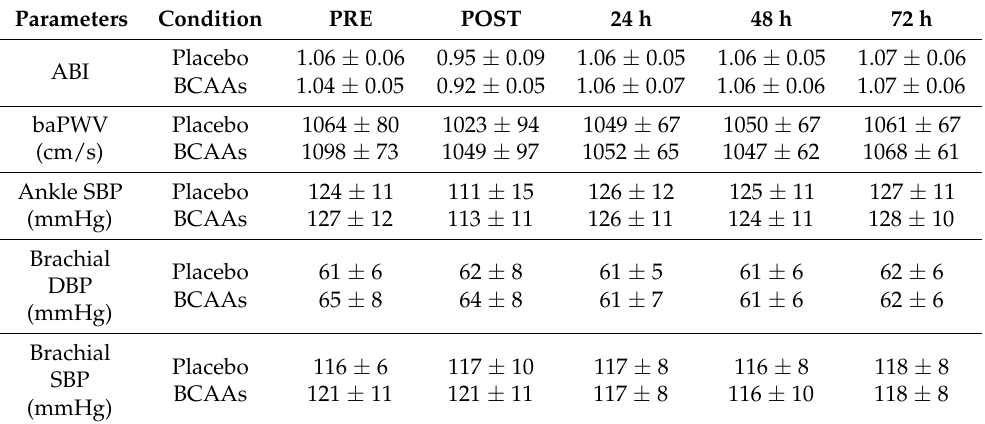
Figure 7. COD deficit time during the time course of recovery. (*) Denotes differences ( p < 0.05) from all time-point measurements. Table 1. Changes of vascular health variables for BCAAs and placebo supplementation conditions during the time course of recovery (mean ±